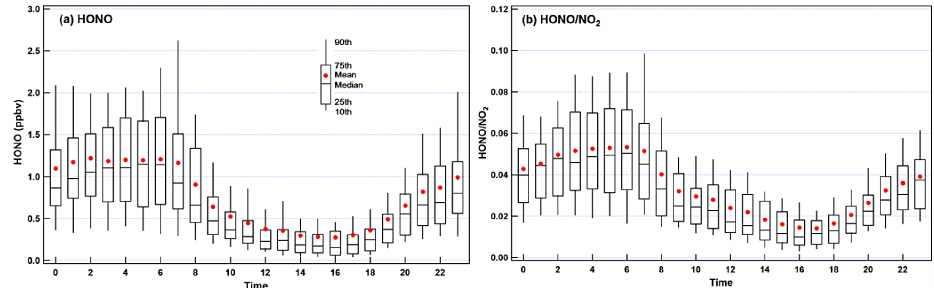
Figure 2. Whisker plot of diurnal variation of (a) HONO and (b) HONO / NO 2 at the SORPES station during April–June